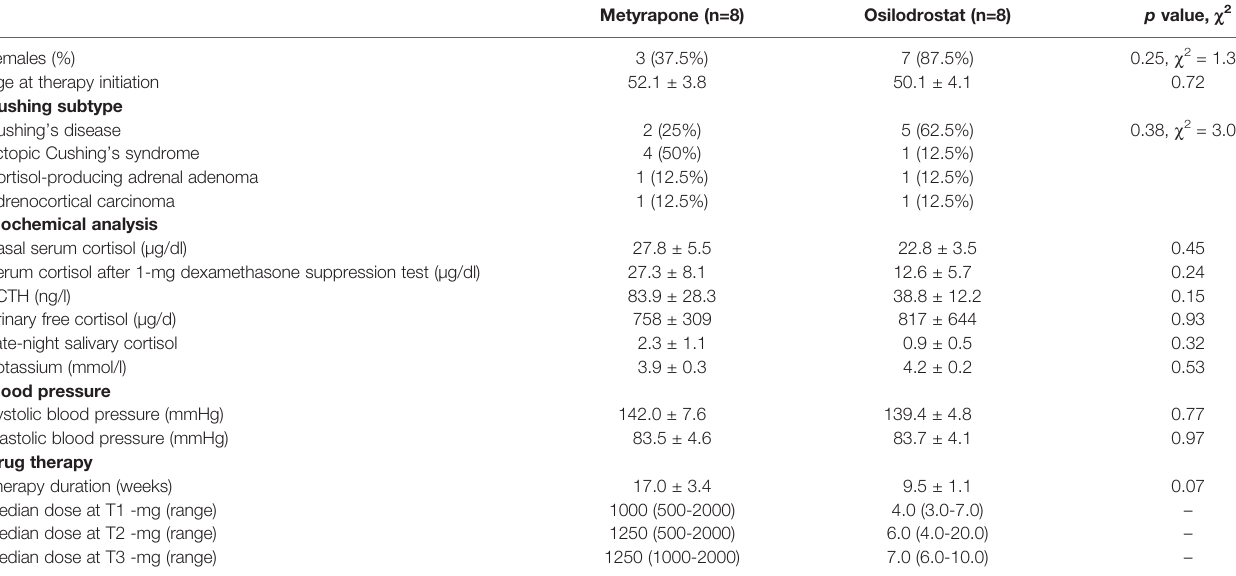
TABLE 1 | Clinical characteristics of the two study